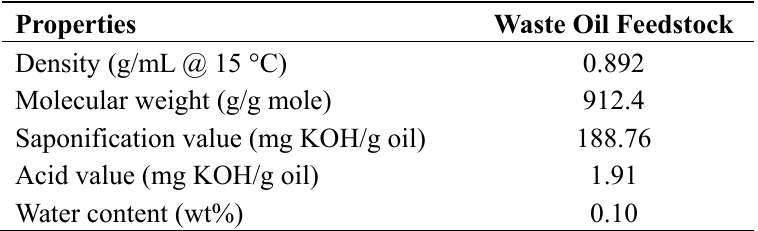
Table 1. Physicochemical properties of waste oil